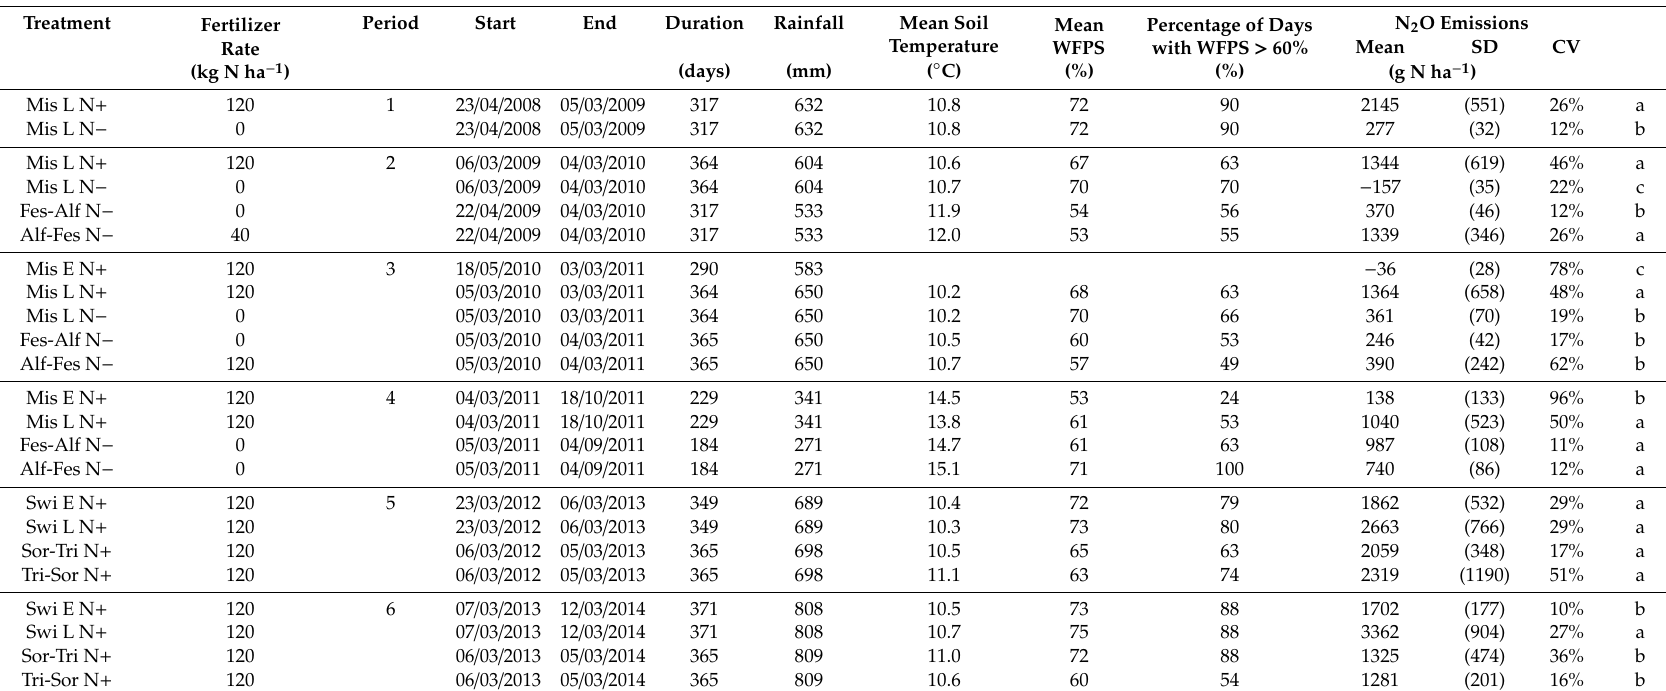
Table 3. Cumulative N 2 O emissions measured in di ff erent treatments during six periods. Values between brackets are standard deviations (SD) between chambers (CV = coe ffi cient of variation). Letters indicate significant di ff erences ( p < 0.05) between treatments for a given period. See Table 1 for treatment